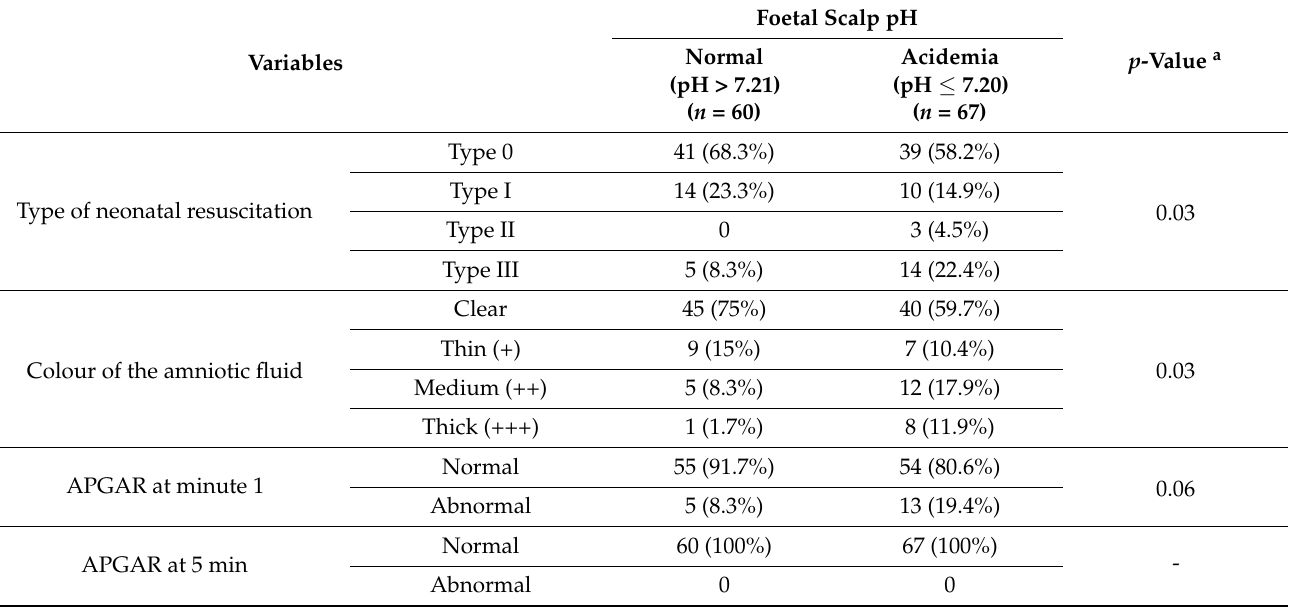
Table 3. Comparison of the normal and acidemia foetal scalp pH based on the type of neonatal resuscitation required, the colour of the amniotic fluid and the APGAR